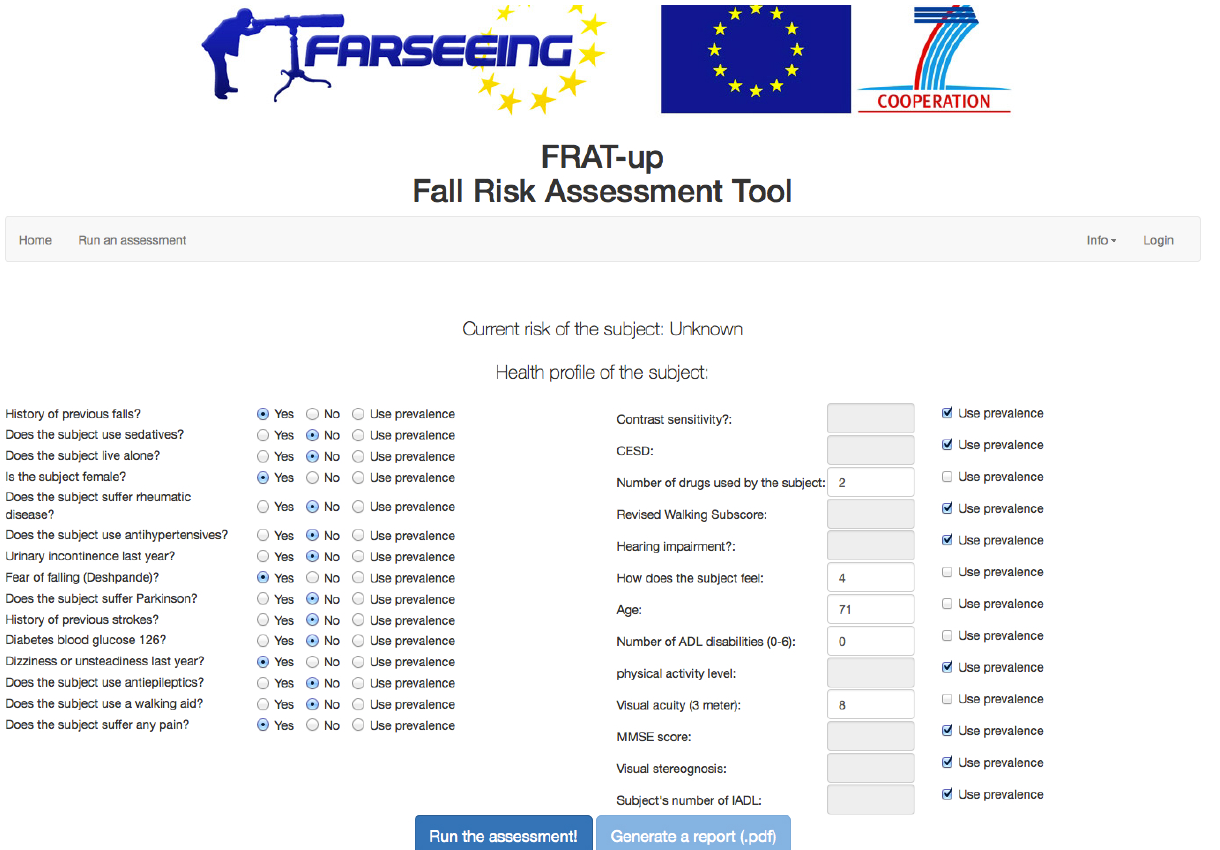
Figure 14. Screenshot of the Web-based